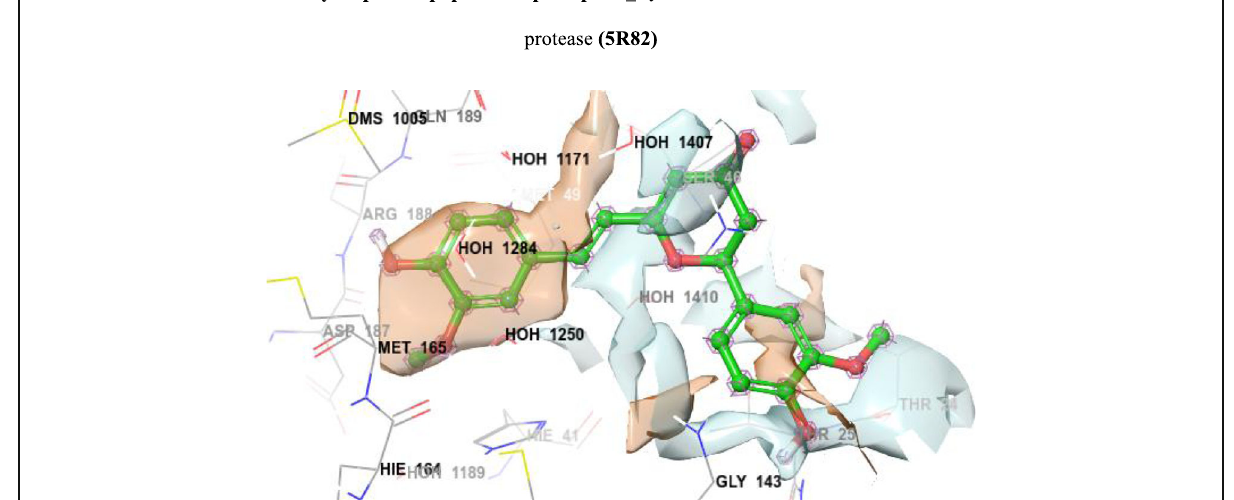
Fig. 6 Hydrophilic/lipophilic map of cpd T4_Cyclocurcumin with SARS CoV-2 main protease